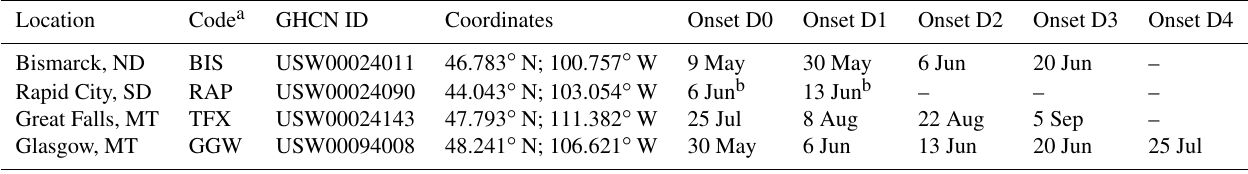
Table 1. Climate stations from Global Historical Climatology Network (GHCN) and onset of drought stages (D0–D4, according to the US Drought Monitor, USDM) for the 2017